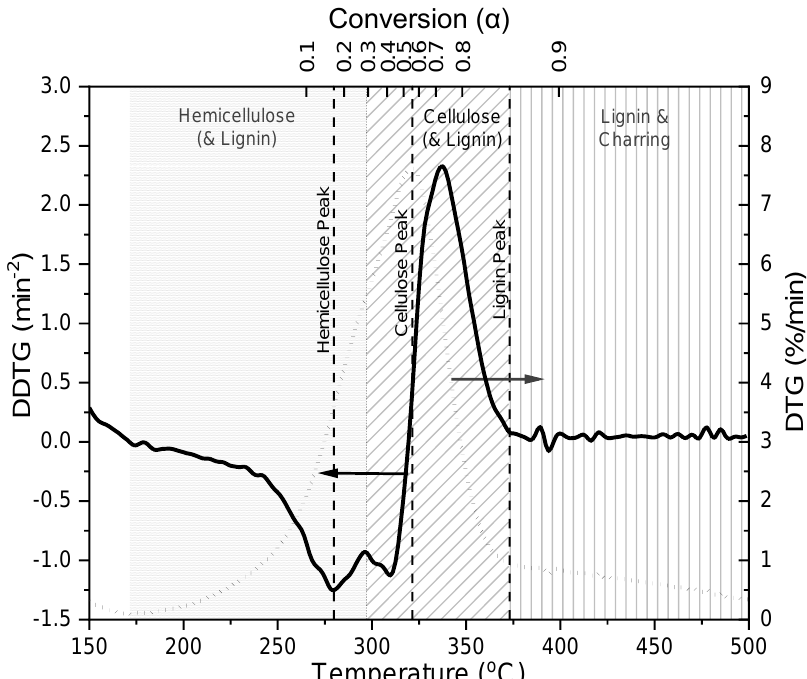
Figure 1. Use of the second derivative (DDTG, in black) inflection points to determine the peak/transition points for the different pseudo-components (PCs) based on the works of Gaitán-Á lvarez et al. [11] and Wu et al. [7]. Example using wheat straw hull at 10 K·min −1 .